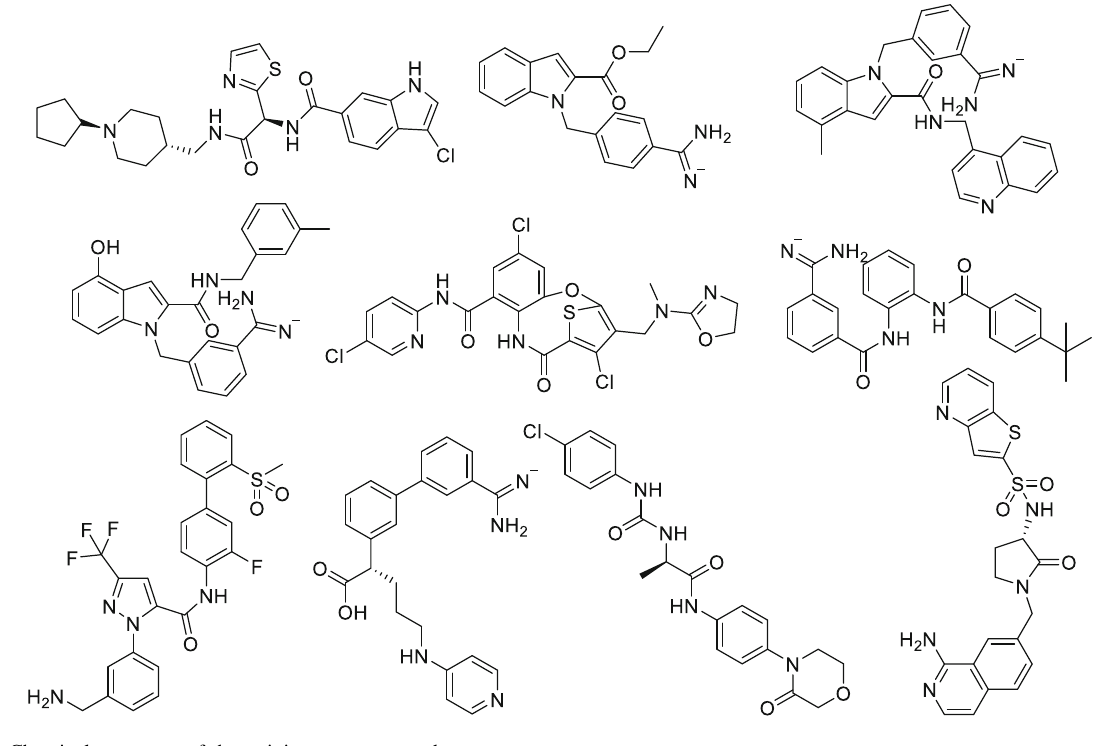
Fig. 2 Chemical structures of the training set